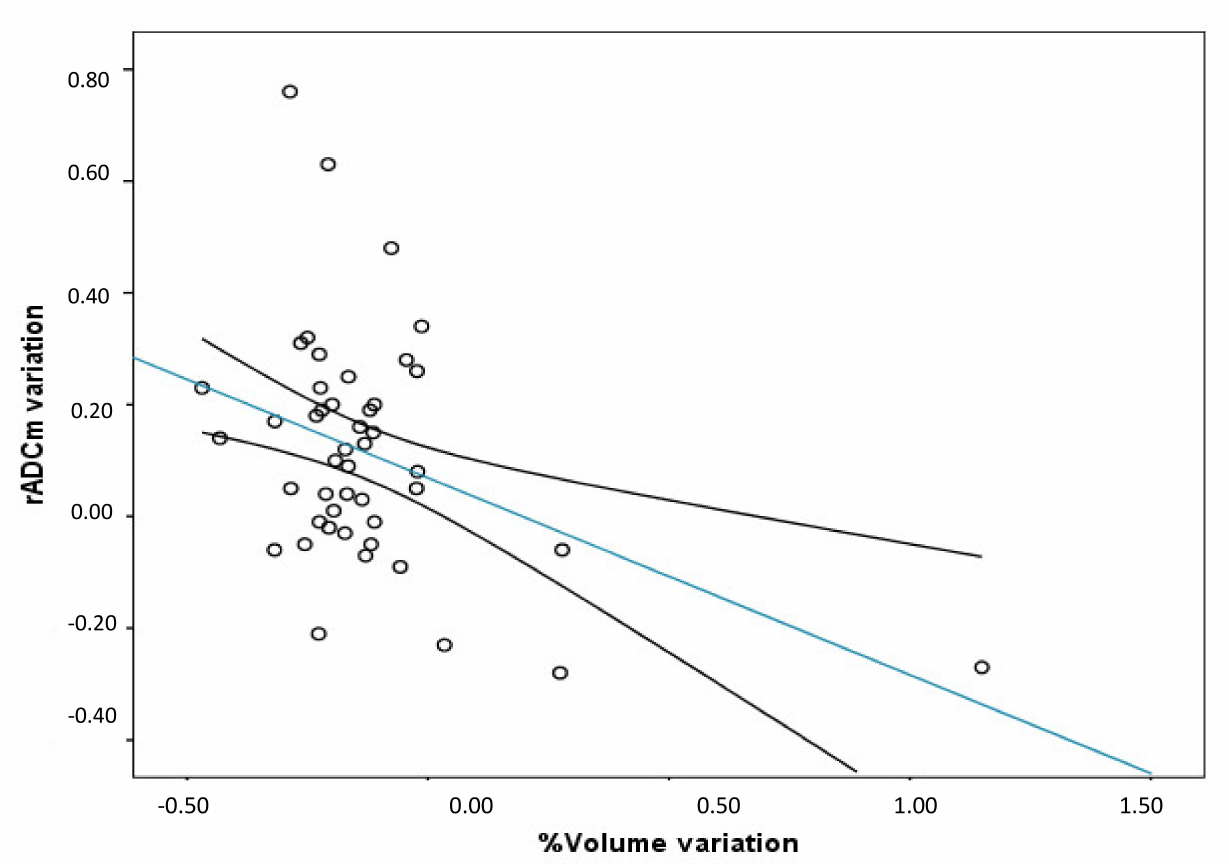
Figure 4. Between the variation of rADCm (Last rADC-Pre rADCm) and volume variation percentage. A significant negative correlation between the variables was found (r = − 0.40; p = 0.0048; r 2 = 0.21. (Trend line and mean confidence interval are